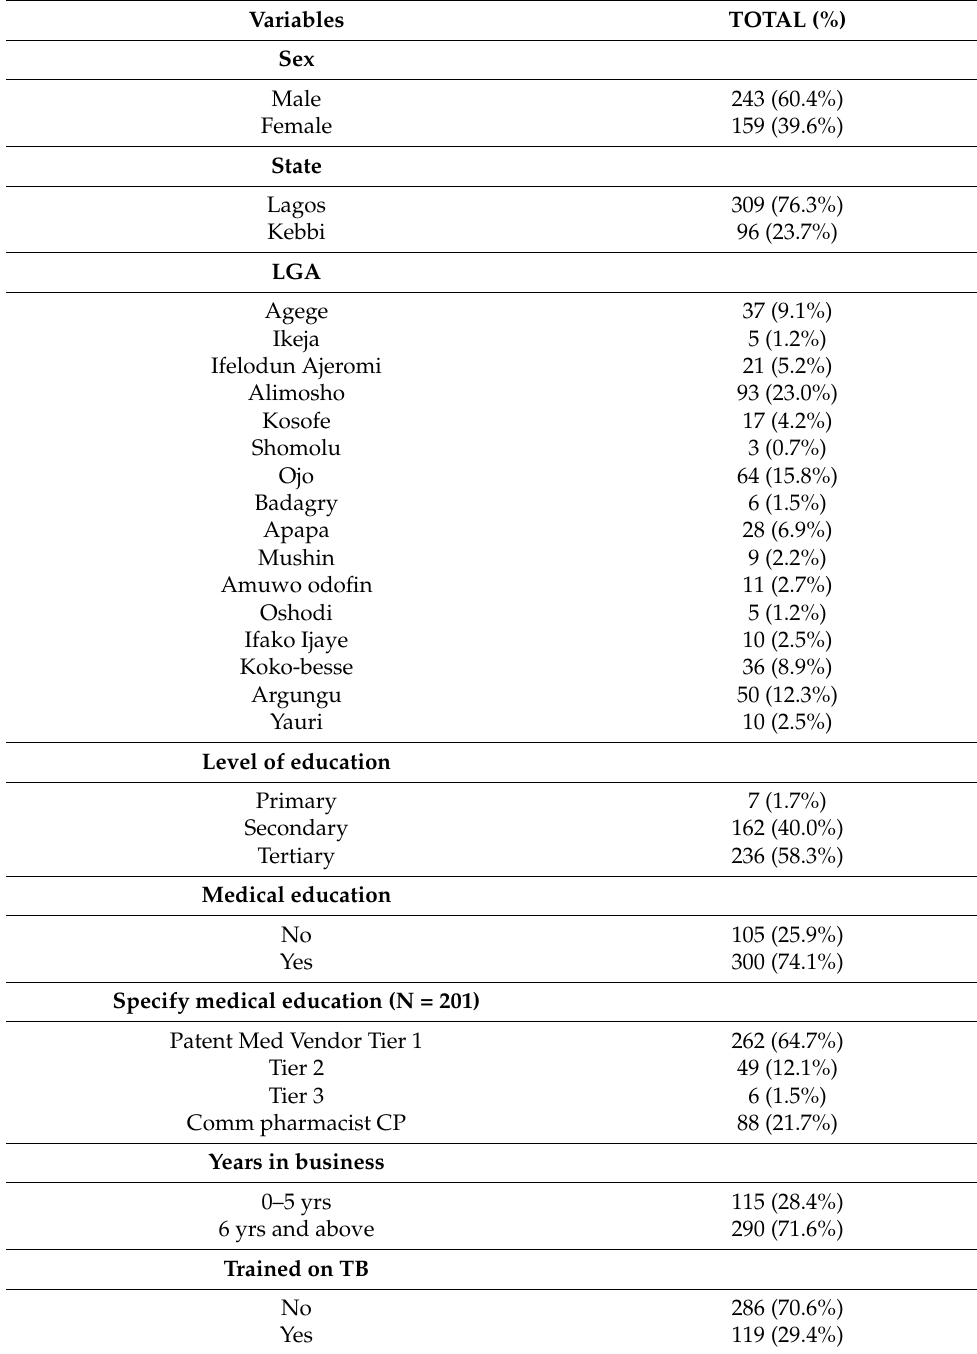
Table 1. Sociodemographic characteristics of